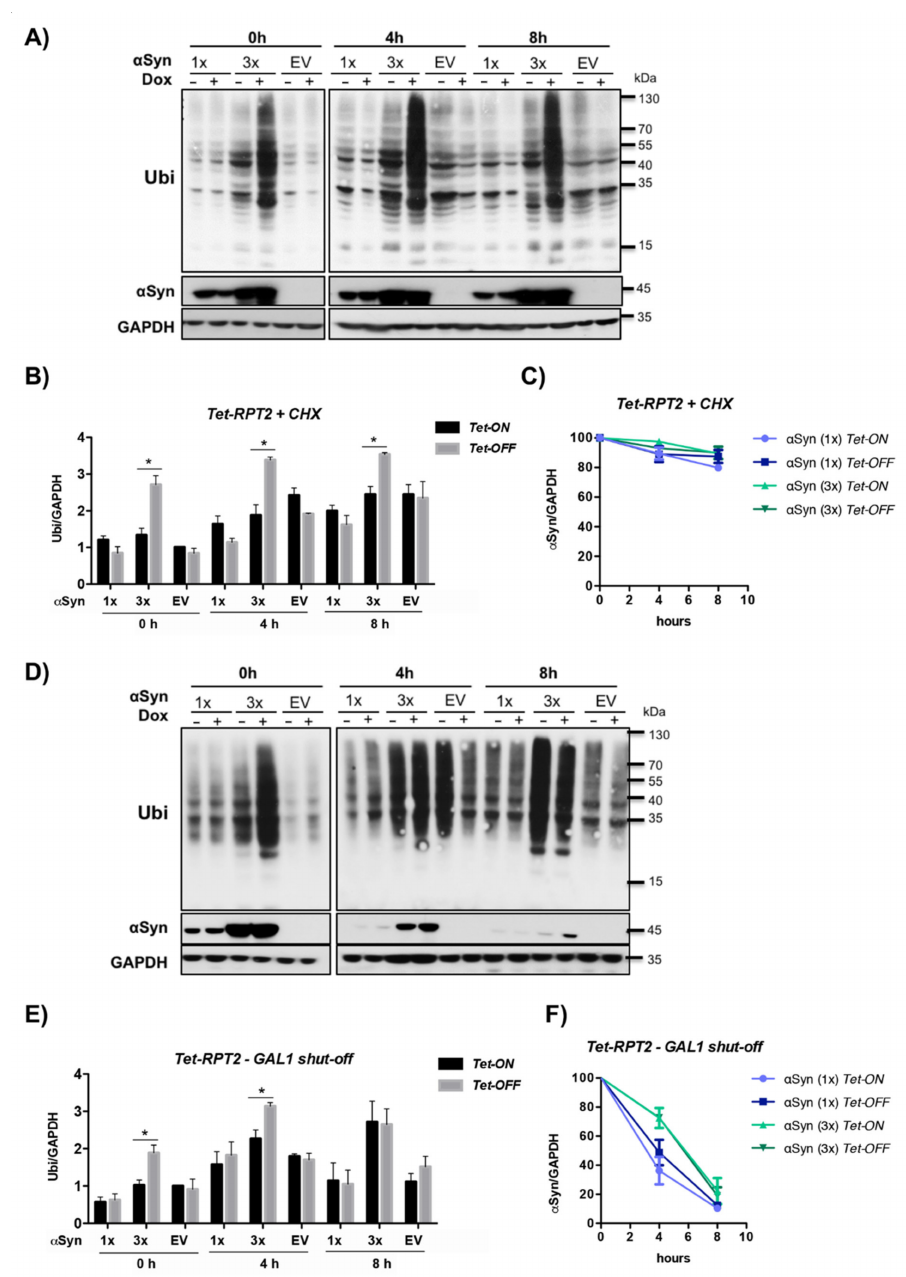
Figure 9. High level of α Syn increases the pool of ubiquitinated substrates upon downregulation of Tet-RPT2 . ( A ) Western blot analysis of Tet-RPT2 mutant strains treated with cycloheximide. Strains harboring one (1 × ) or three (3 × ) gene copies of α Syn or empty vector (EV) as a control were grown overnight in galactose medium to induce α Syn expression. The Tet promoter was downregulated by addition of 10 µ g/mL doxycycline to the growth medium. Afterwards, cells were treated with 50 µ g/mL cycloheximide to stop de novo protein synthesis. Immunoblotting analysis was performed at the indicated time points after addition of cycloheximide with ubiquitin (Ubi) or α Syn antibodies. GAPDH was used as a loading control. ( B ) Densitometric analysis of the immunodetection of high-molecular weight ubiquitin conjugates relative to the GAPDH loading control. The ubiquitin/GAPDH ratio was normalized to the ratio of EV ( Tet -ON) at 0 h. The significance of the differences was calculated with a t -test (*, p < 0.05; n = 3). ( C ) Densitometric analysis of the immunodetection of α Syn relative to the GAPDH loading control. The α Syn/GAPDH band ratio was normalized to the corresponding ratio at 0 h and presented as a percentage.